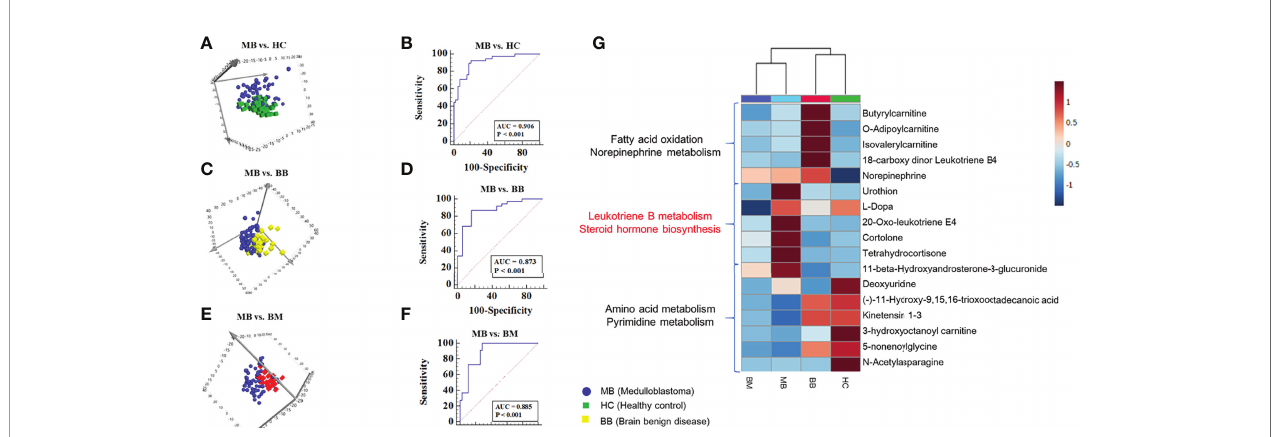
FIGURE 2 | Analysis of urine metabolomics of medulloblastoma, healthy controls, benign brain diseases, and malignant brain tumors. (A). PCA score plot of MB and controls in the discovery group. (B). ROC plot of the distinction between MB and controls in the validation Group (C). PCA score plot of MB and benign brain diseases in the discovery Group (D). ROC plot of the distinction between MB and benign brain diseases in the validation Group (E). PCA score plot of MB and other malignant tumors in the discovery group. (F). ROC plot of the distinction between MB and other malignant tumors in the validation group (G) . Heatmap of 60 metabolites in MB, healthy controls, benign brain diseases and other malignant brain tumors.